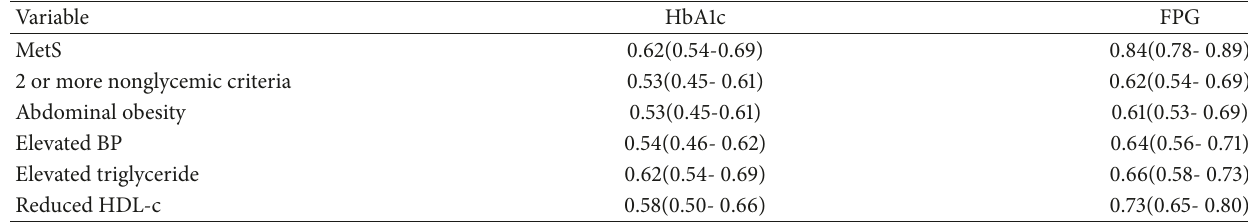
Table 5: AUC for HbA1c and FPG in predicting MetS and its